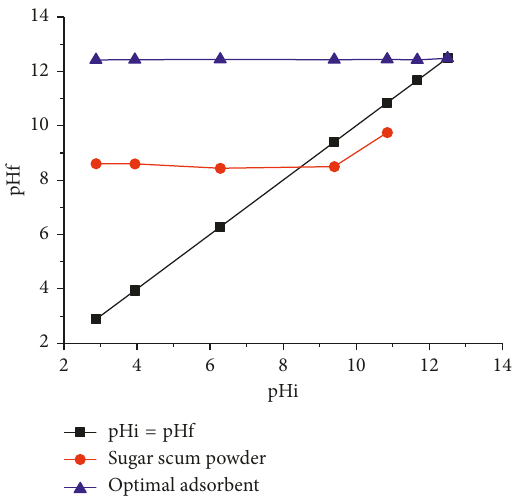
Figure 11: The pH